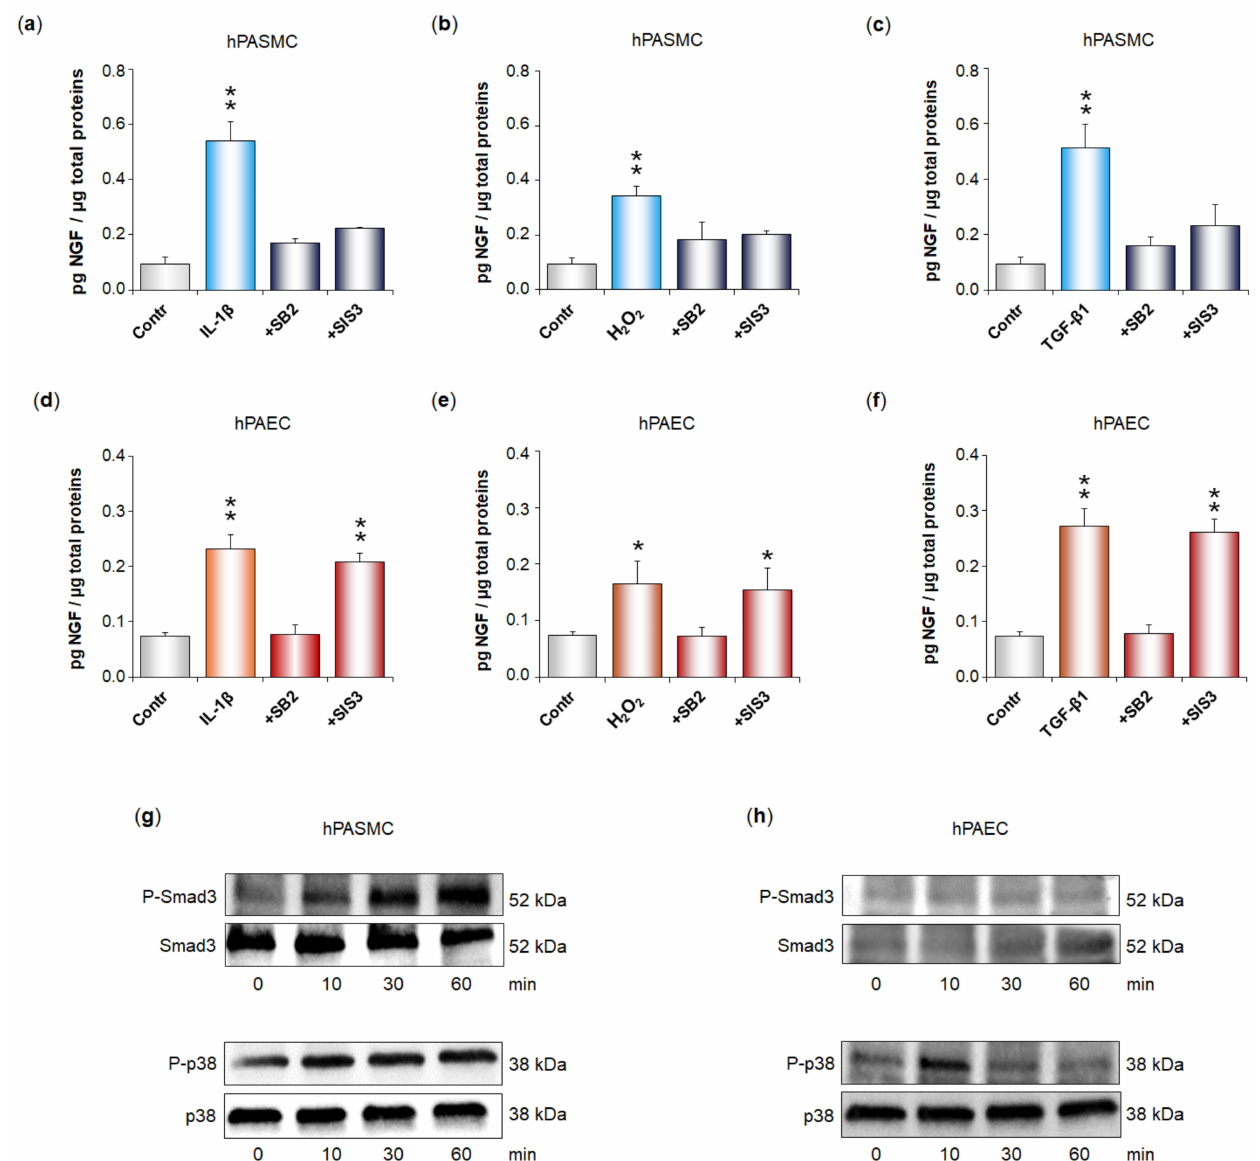
Figure 6. Signaling pathways activated by the TGF- β 1 receptor T β RI in human pulmonary arterial cells to participate in the IL-1 β - or H 2 O 2 -induced increase in NGF secretion by these cells. ( a – f ) NGF secretion by human pulmonary arterial smooth muscle cells (hPASMC, ( a – c )) or human pulmonary arterial endothelial cells (hPAEC, ( d – f )) was assessed in the absence or presence of interleukin-1 β (IL-1 β , 10 ng/mL, 24 h), hydrogen peroxide (H 2 O 2 , 10 µ M, 24 h), or TGF- β 1 (5 ng/mL, 24 h). Signaling pathways involved were investigated through cell pre-treatment (45 min) with the p38 inhibitor SB203880 (+ SB2, 2 µ M) or with the Smad3 inhibitor SIS3 (+SIS3, 10 µ M). NGF secretion was determined by ELISA (results expressed as pg NGF/ µ g total proteins). The data represent the means ± SEM of n = 3 independent experiments performed in triplicate on cells from three control donors. * p < 0.05 and ** p < 0.01 versus untreated control cells (Contr). ( g,h ) Time-course of TGF- β 1-induced phosphorylation of Smad3 and p38 in ( g ) hPASMC or ( h ) hPAEC. Cells were incubated with TGF- β 1 (5 ng/mL) for 10–60 min, and Western blotting analysis used anti-phospho-Smad3 or anti-phospho-p38 antibodies, as well as anti-Smad3 and anti-p38 antibodies as controls. The immunoblots presented are representative of experiments conducted on pulmonary arterial cells from n = 2–4 control donors, showing identical